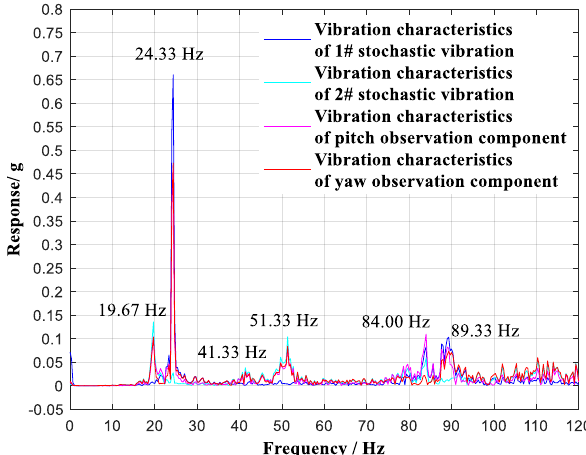
Figure 13. Comparison of vibration characteristics with continuous lifting (γ = 0°) of the aircraft model at Ma = 0.6.